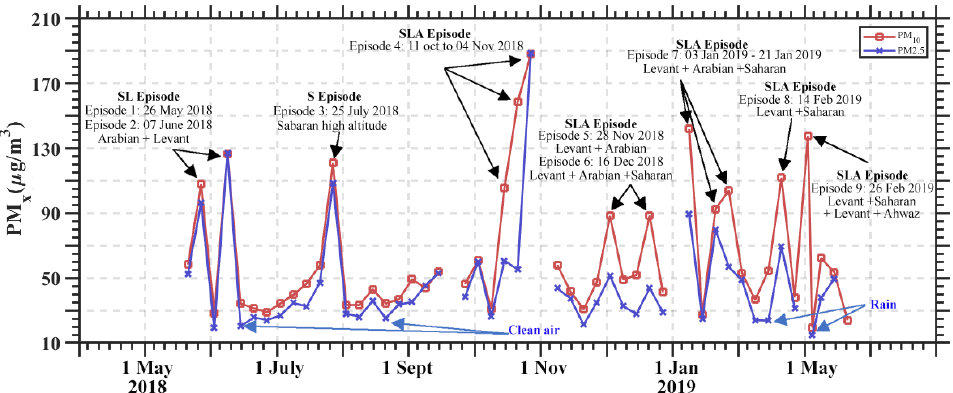
Figure 2. Daily average PM concentrations were measured at the in situ station with markups for sand and dust episodes (SDS), precipitation, and clean air